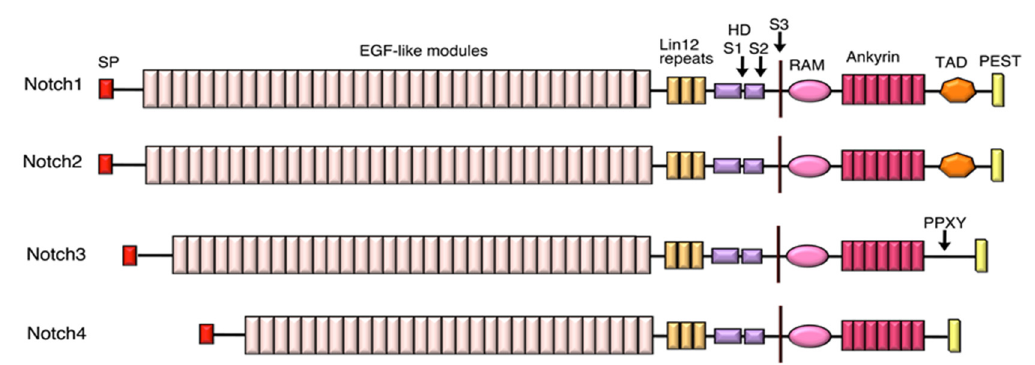
Figure 1. Domain structure of human Notch proteins. Schematic view comparing the domain structure of human Notch proteins. SP (signal peptide), EGF (epidermal growth factor), HD (heterodimer region), TAD (transcription factor activation domain), PEST (domain rich in proline, glutamate, serine and threonine). Locations of S1, S2 and S3 cleavage sites are indicated. PPXY motif in Notch3 acts as a WW domain recognition site for the endocytic regulator WWP2.